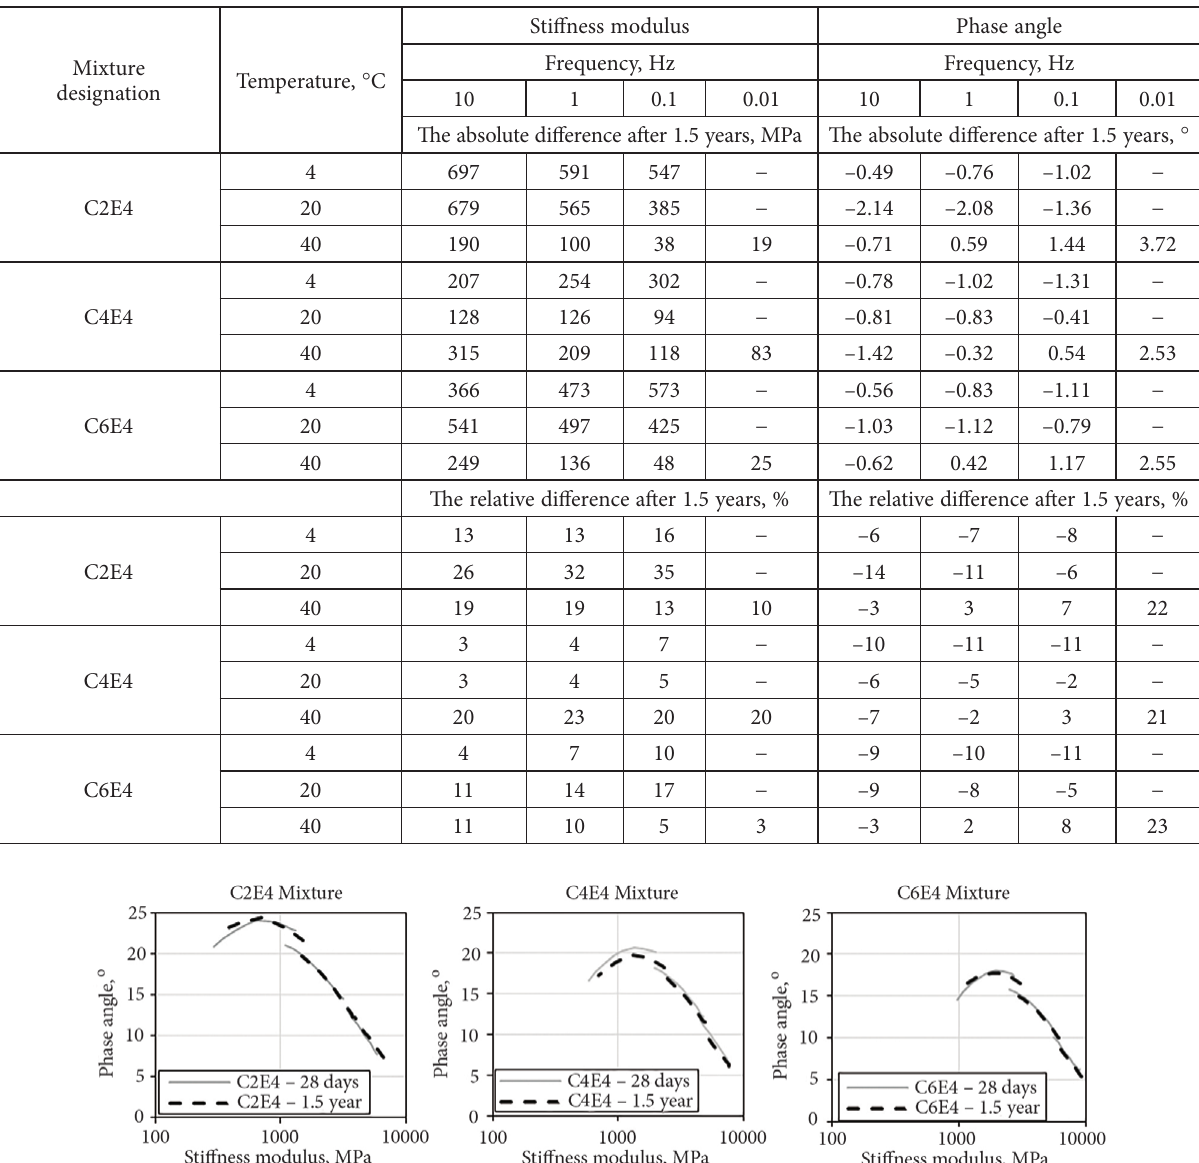
Table 4. The differences in values of stiffness moduli and phase angles measured after 28 days and after 1.5 years